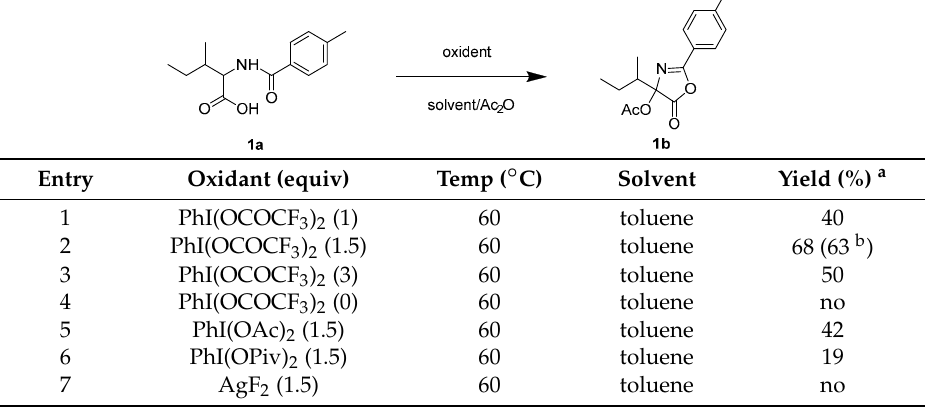
Table 1. Direct α -oxidation of N -benzoyl amino-acid using hypervalent iodine.